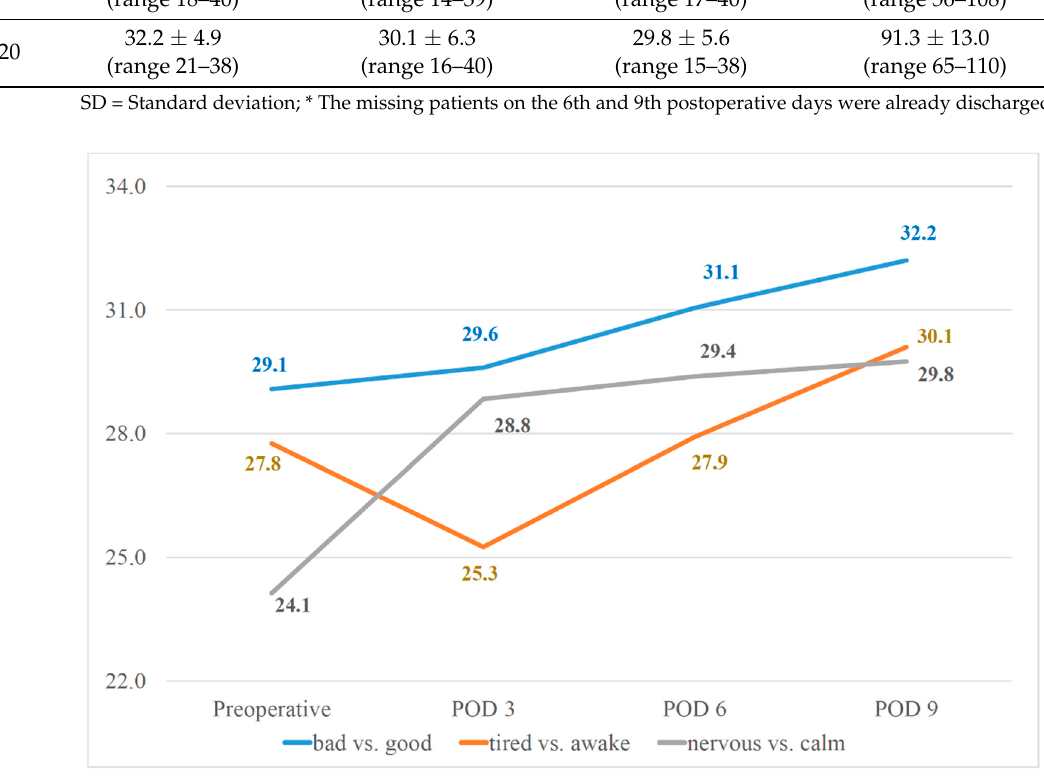
Figure 2. Course of multi-dimensional mood questionnaire results (blue line: mood (bad. vs. good), orange line: wakefulness (tired vs. awake), grey line: arousal (nervous vs. calm); POD = postoperative day). The mood increased continually from the preoperative day to POD9. Patients were the most tired on the 3rd postoperative day and the most nervous preoperatively and calmed down postoperatively.